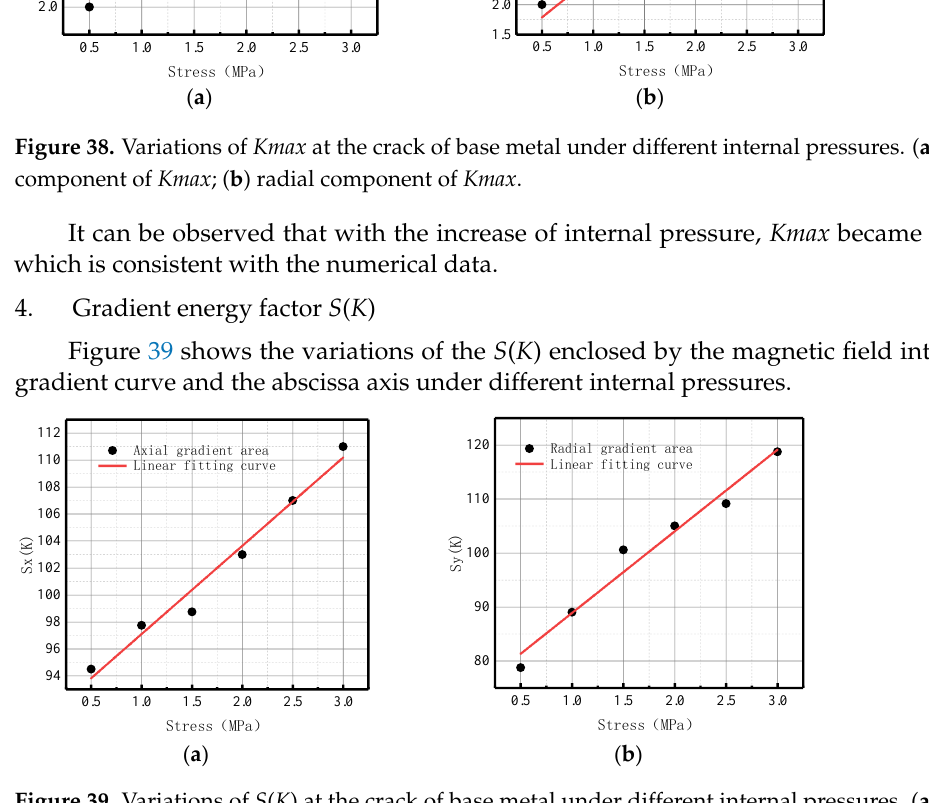
Figure 39. Variations of S ( K ) at the crack of base metal under different internal pressures. ( a ) Axial component of S ( k ); ( b ) radial component of S ( k ).